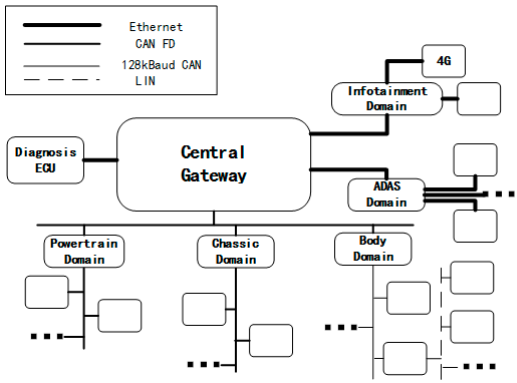
Figure 2. CAN FD and Ethernet serving as a backbone in vehicles.